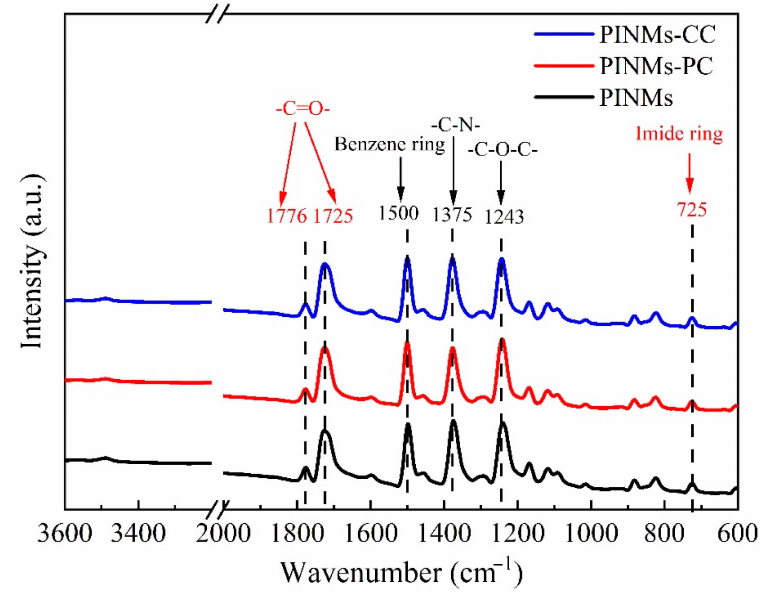
Figure 2. FT − IR spectrum of PINMs, PINMs − PC and PINMs − CC.